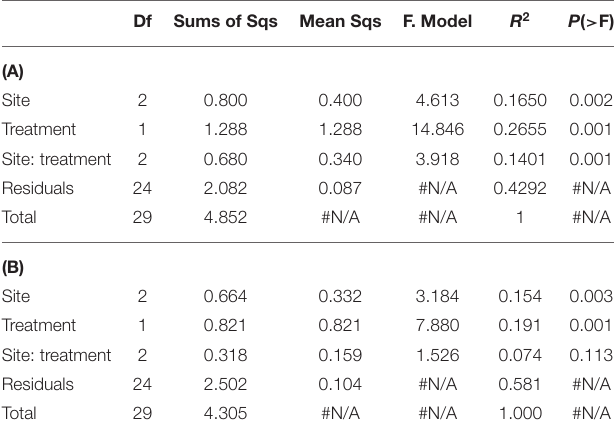
TABLE 3 | PERMANOVA analysis on (A) , trimmed list of detected WSFA eliminating the rare ones -present in less than 20% of the analyzed samples- (see M&M) ( n = 49); and on (B) , trimmed list of detected WSFA that did not show site-treatment interaction. Df Sums of Sqs Mean Sqs F. Model